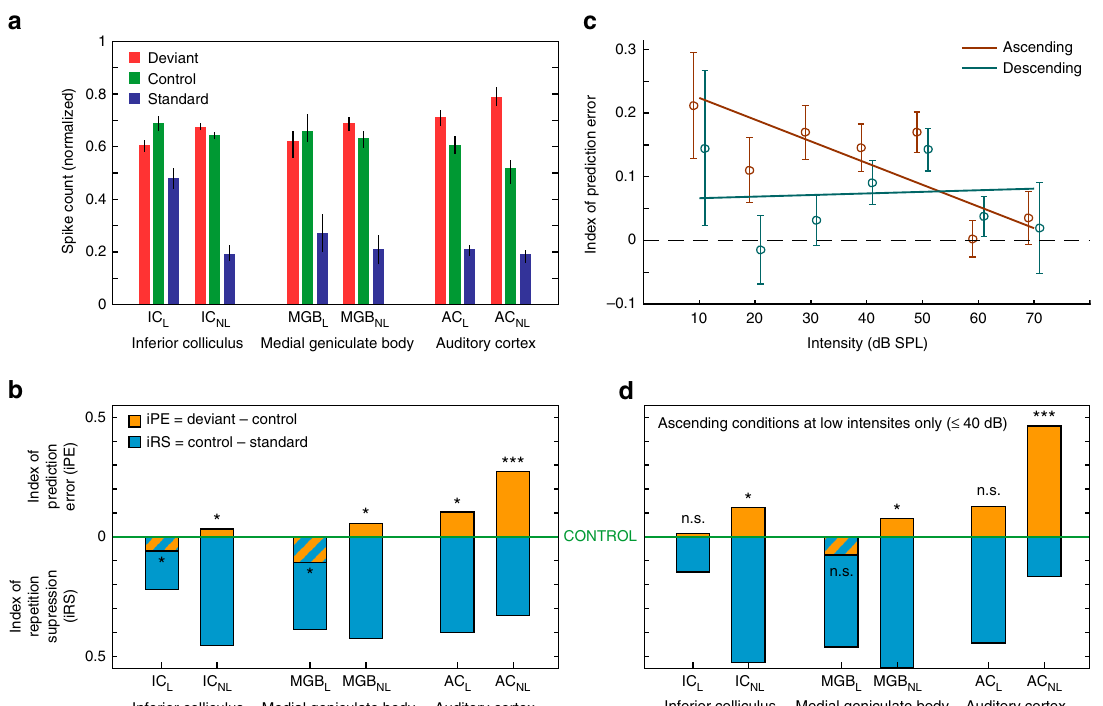
Fig. 4 Emergence of prediction error along the auditory hierarchy. a Median normalized responses (lines indicate SEM) to the deviant, standard and control within each station. b Median indices of prediction error (orange) and repetition suppression (cyan), represented with respect to the baseline set by the control. Thereby, iPE is upwards-positive while iRS is downwards-positive. Each median index corresponds to differences between normalized responses in a . Asterisks denote statistical signi fi cance of iPE against zero median (* p = 0.05, ** p = 0.01, *** p = 0.001, see Table 1). c Linear model fi tted for the iPE using SPL and direction (ascending / descending) as predictors. Error bars denote mean and SEM for each SPL and direction. Note the model predicts greater iPE values for ascending conditions at low intensities. d Same as in b , but only representing ascending conditions at intensities equal or lower than 40 dB